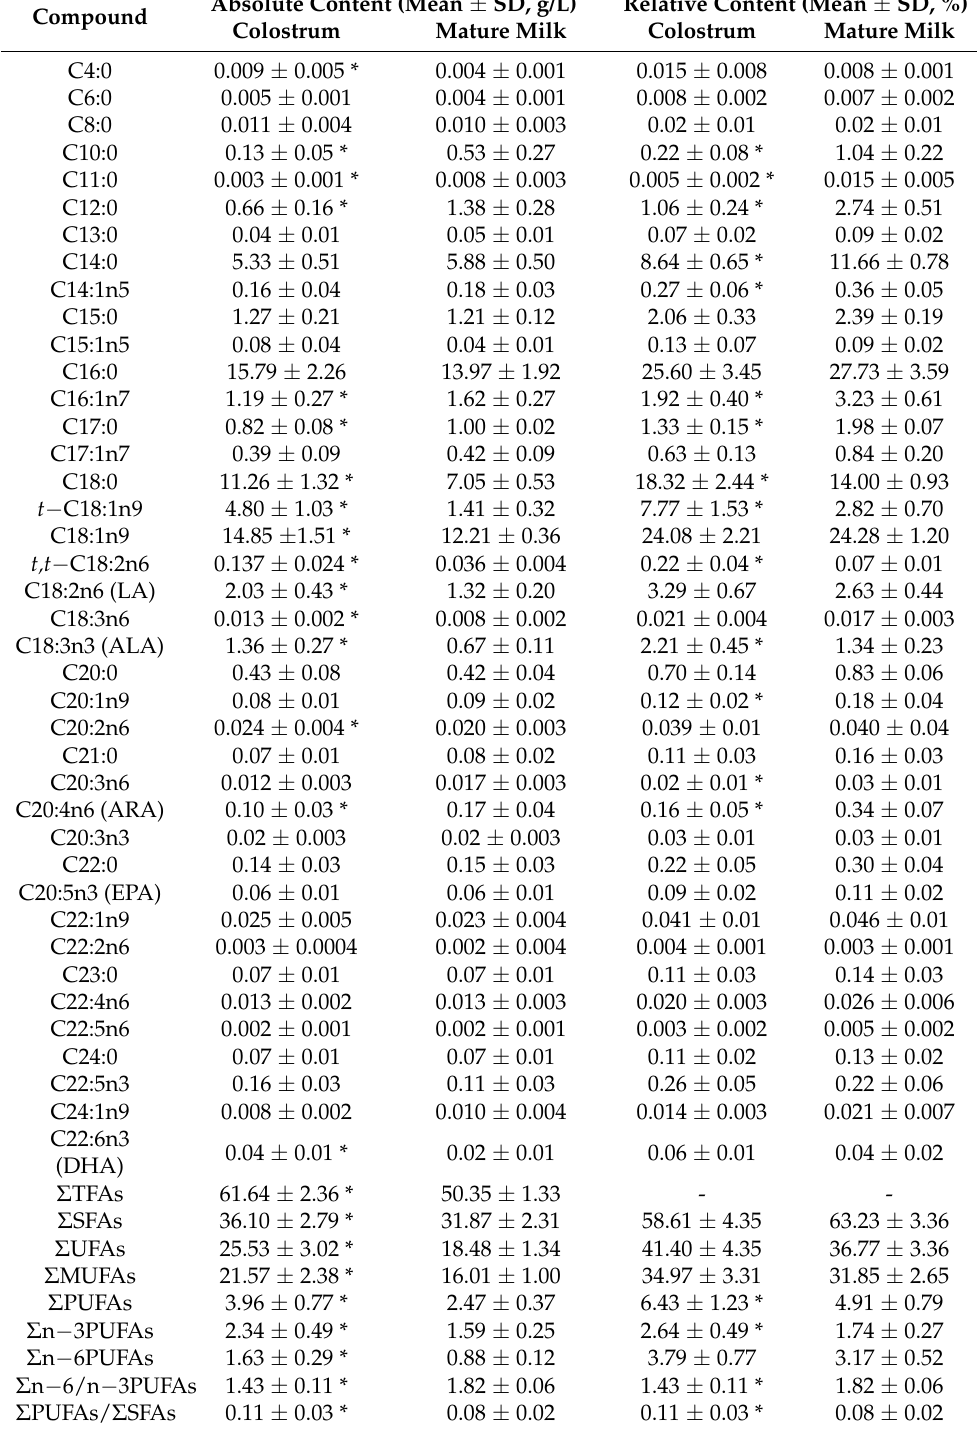
Table 1. The absolute and relative content of fatty acids in yak colostrum and mature